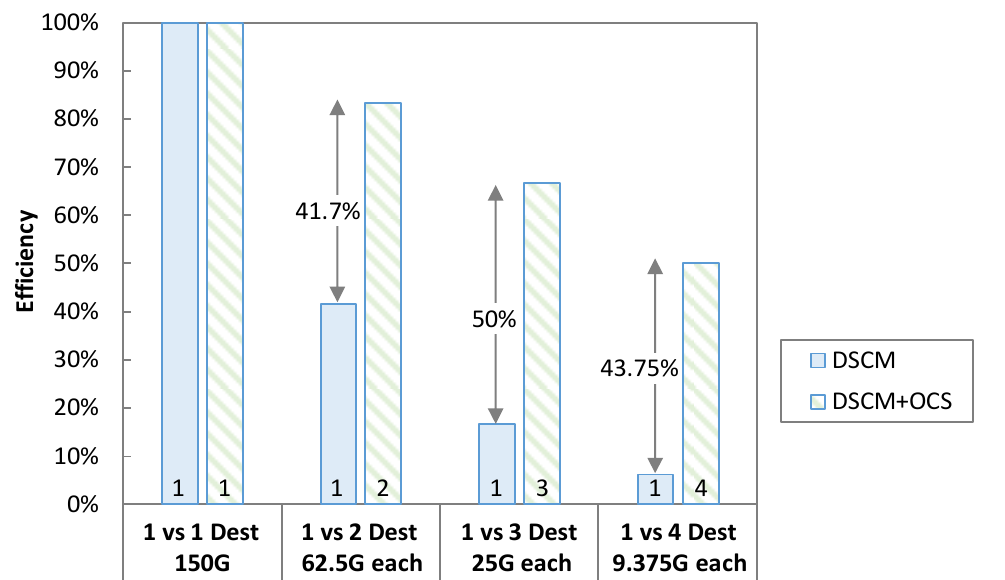
Figure 15. Efficiency improvement for OCS + DSCM.